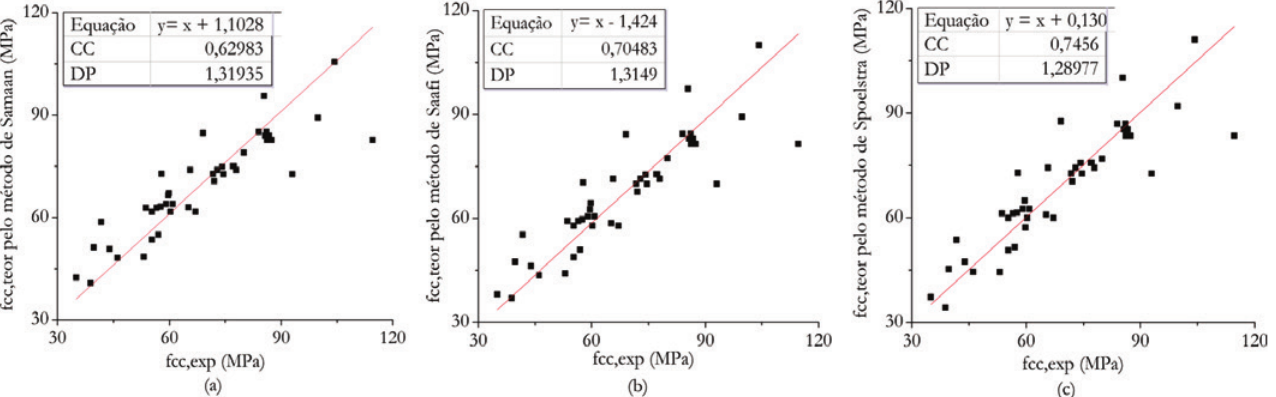
) para os modelos cc